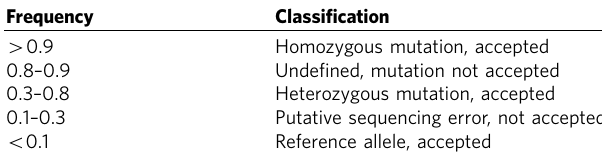
Table 1 | Mutation classification